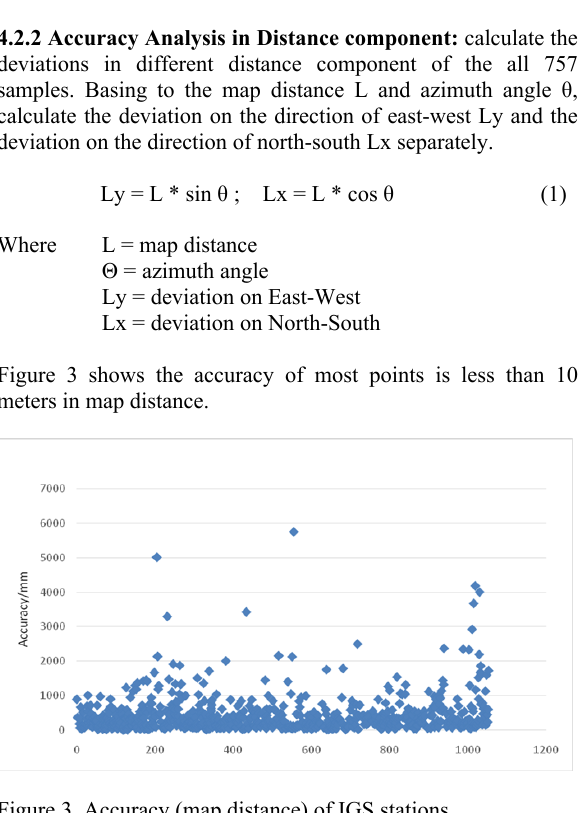
Figure 3. Accuracy (map distance) of IGS stations The North-South component of each point is represented by "N". “+” stands for the deviations in North and “-” stands for the South direction; The East-West component is represented by "E". “+” stands for the deviations in North and “-” stands for the south direction. The vertical component (altitude difference) is always "U".